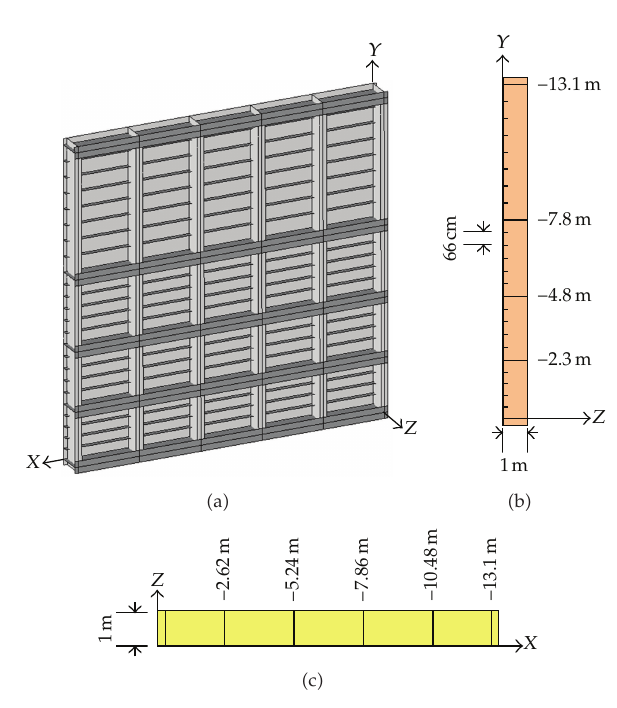
Figure 29: Numerical model of gate 1.